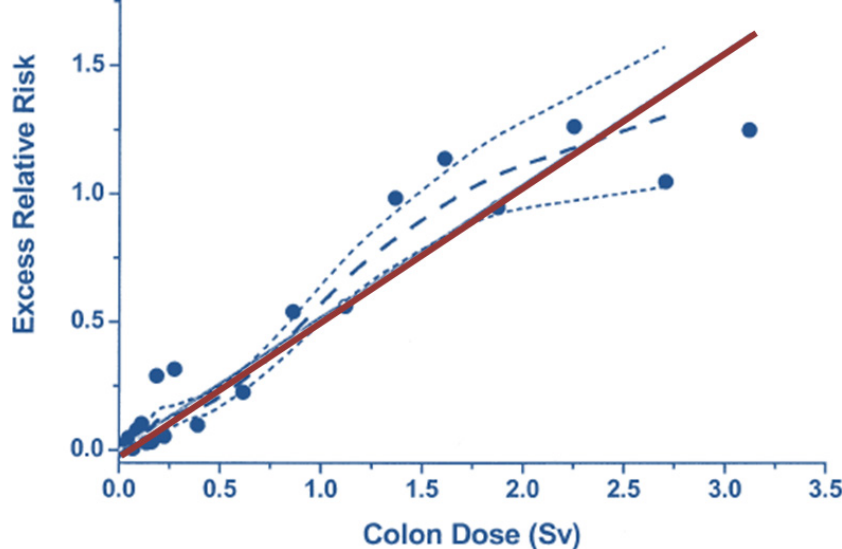
Figure 3. Excess relative risk of solid cancers derived from the Life Span Study cohort of A-bomb survivors over the dose range 0 to 2 Sv, to which a straight line is fitted. The solid straight line is the linear slope estimate, the points are dose category-specific ERR estimates, the dashed curve is a smoothed estimate derived from the points. The dotted curves indicate upper and lower one-standard-error bounds on the smoothed estimate (reproduced with permission from [8]).